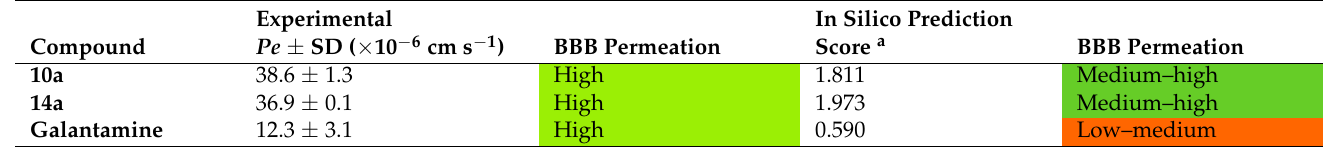
Table 5. Permeability results (Pe) in the PAMPA-BBB assay and in silico